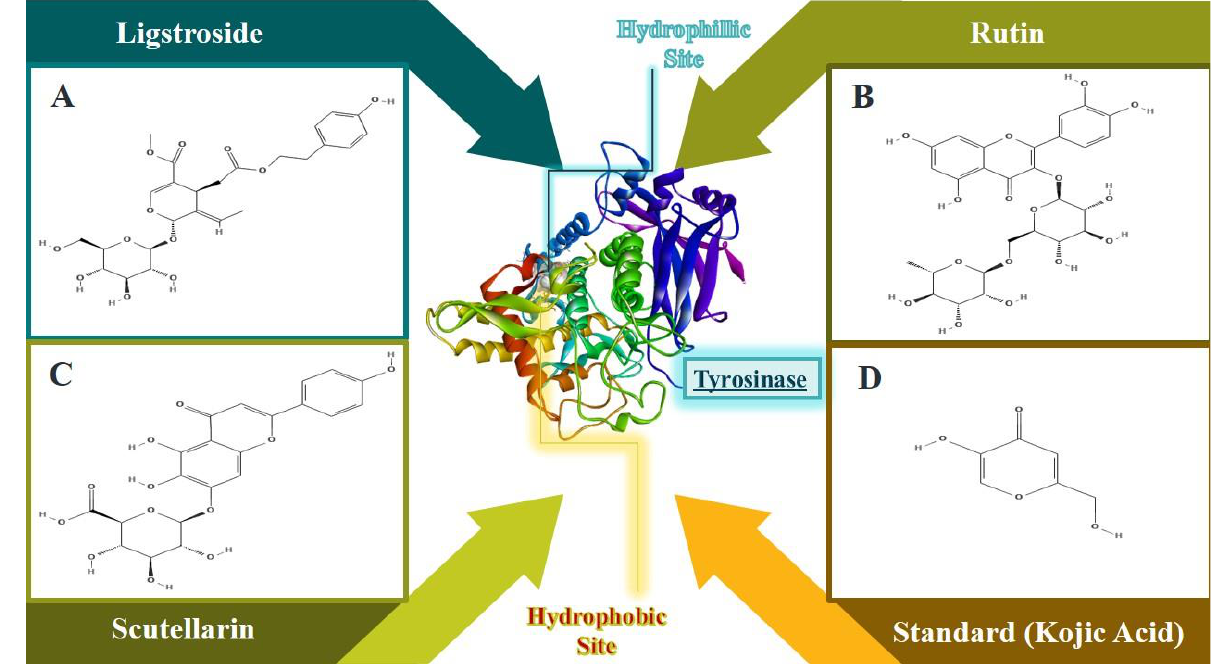
Figure 5. Enzyme α -amylase and ligands interaction. Hexadecanoic acid ( A ), Lupeol ( B ), β -A myrin